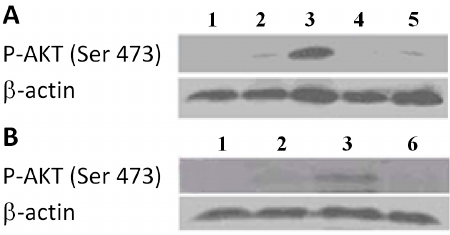
Figure 3. The phosphorylation of AKT/PKB (Ser 473) could be inhibited by compound 1 , 3a and 3 ( A ) Representative western blot bands of P-AKT in MDA-MB-231 cells, ( B ) Representative western blot bands of P-AKT in HGC-27 cells; 1: Control, 2: LY294002 stimulated by 20 µmol/L 20 min before FBS 20 min, 3: FBS incubated at FBS 20 min, 4–6: Compound 3a , 1 and 3 stimulated by 10 µmol/L 2 min before FBS 20 min, respectively).